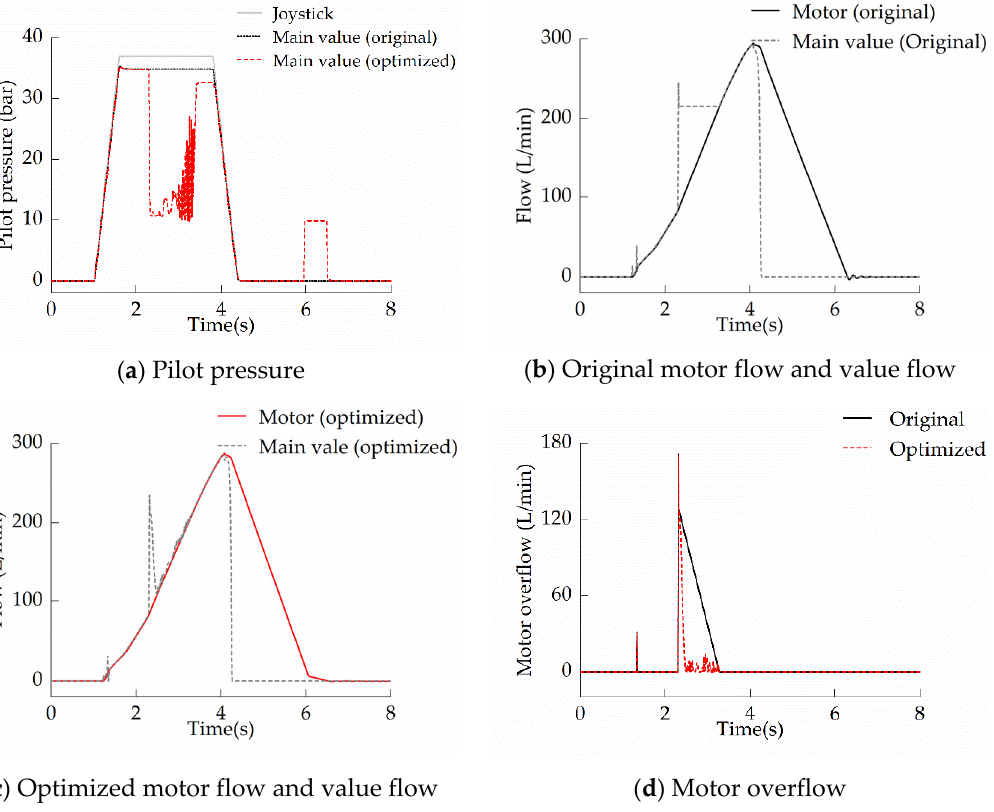
Figure 11. Operational characteristics of a swing system (compound-swing).